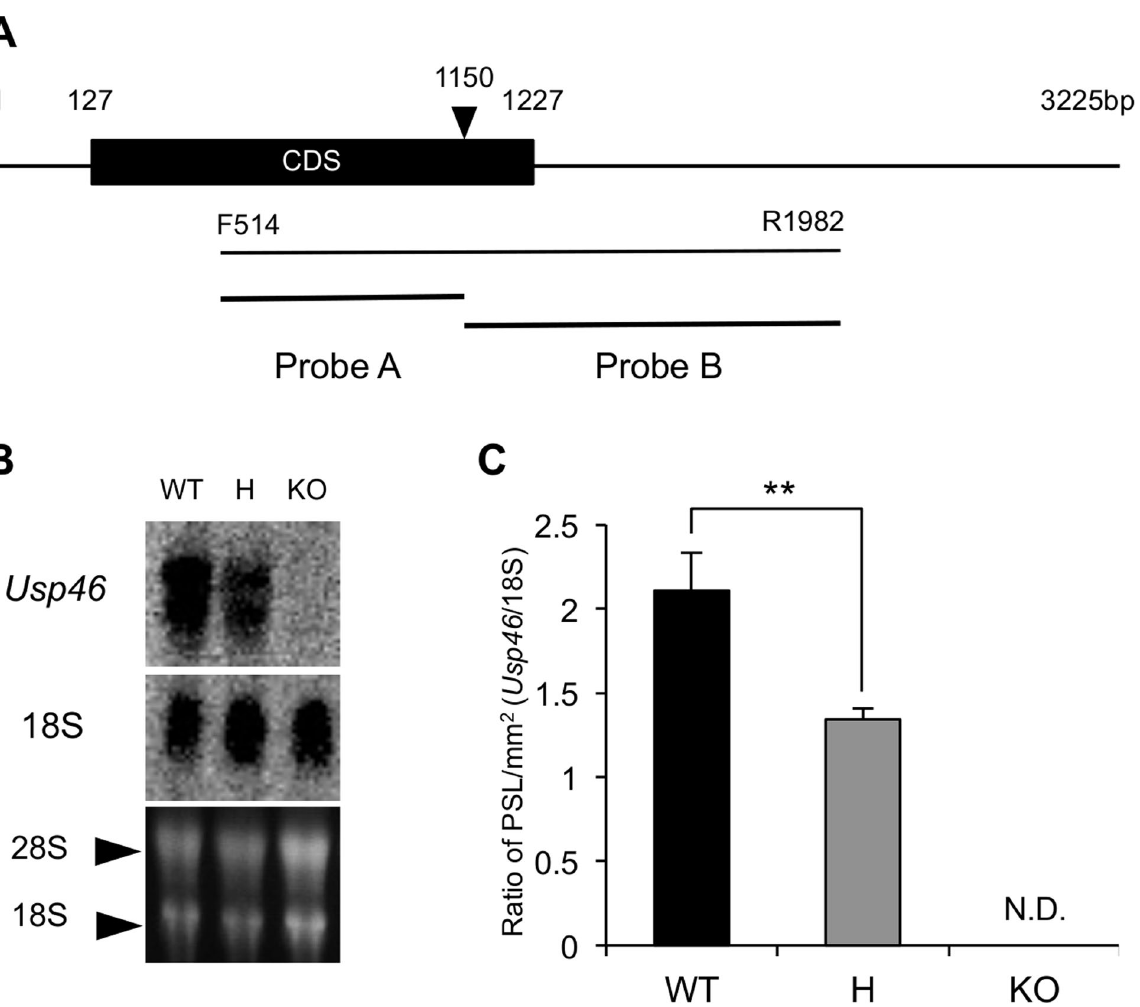
Figure 2. Expression of Usp46 mRNA in the brain analyzed by northern blot analysis. (A) Schematic diagram of cDNA and probes for Usp46 . Probes A and B were used for the northern blot analysis. Black arrowhead indicates the EcoR1 site. F514 and R1982 are a primer pair for PCR. (B) Northern blot from brain total RNA hybridized with the mouse Usp46 cDNA probes A and B, labeled with [ a - 32 P] dCTP. The blot was hybridized with a cDNA probe for S18 as an internal control (the middle panel). The bottom panel shows a photograph of an RNA gel, indicating that equivalent amounts of total RNA were used in each lane. (C) Relative values of Usp46 mRNA. PSL (Photo stimulated luminescence) was measured. Signals from the Usp46 KO mice (KO) were not detected (N.D.). The differences between the wild-type mice (WT) and the heterozygotic mice (H) were significant (** P , 0.01, n=6, Student’s t -test).